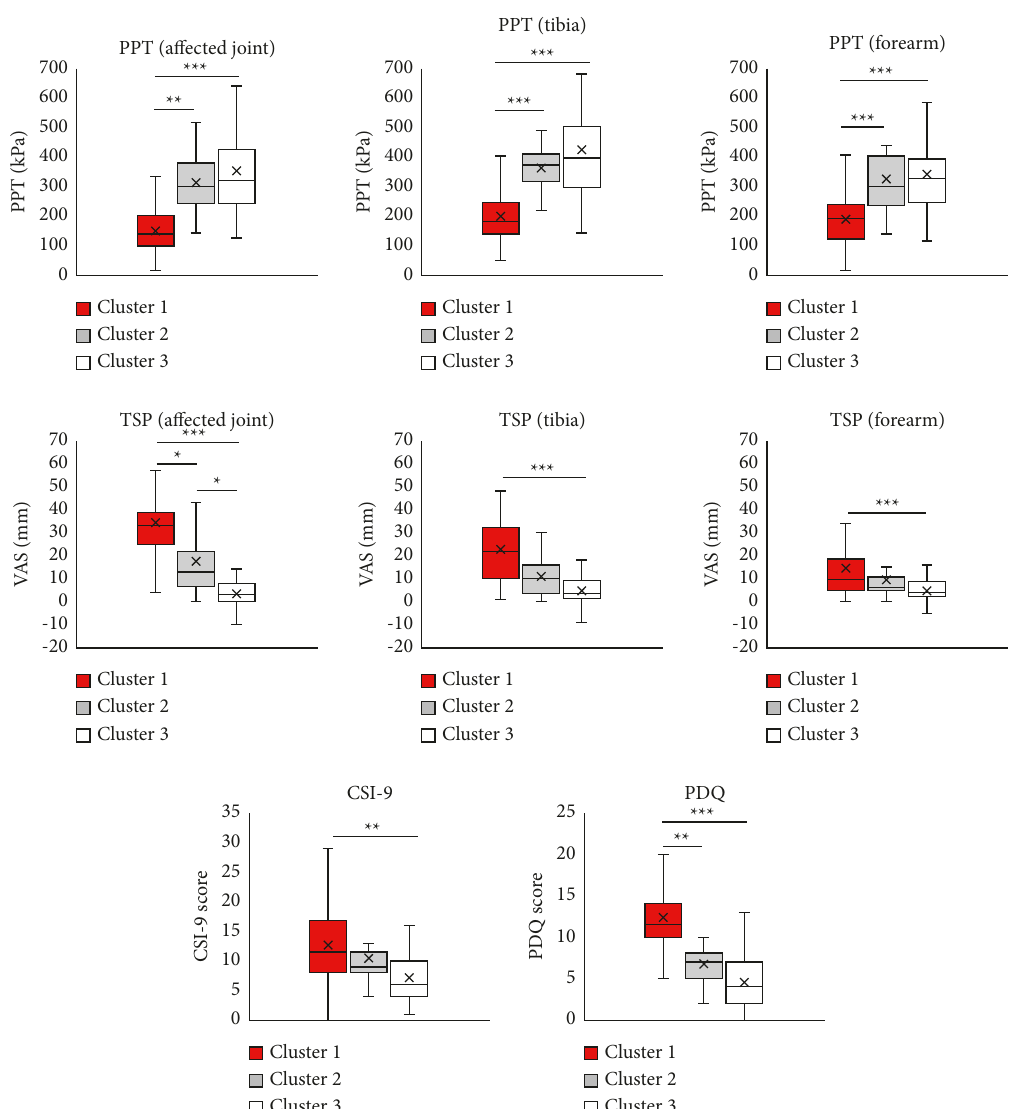
Figure 3: Pressure pain threshold, temporal summation of pain, Central Sensitization Inventory-9, and painDETECT Questionnaire of each cluster. Data are presented as mean ( P 0 . 05 , 0 . 01 , 0 . 001, respectively). PPT, pressure pain threshold; TSP, temporal summation of pain; CSI-9, Central Sensitization Inventory- 9; PDQ, painDETECT Questionnaire; VAS, visual analog <